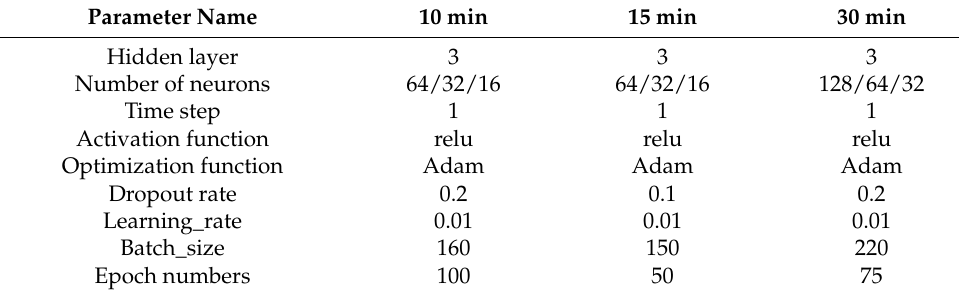
Table 2. Model parameters.